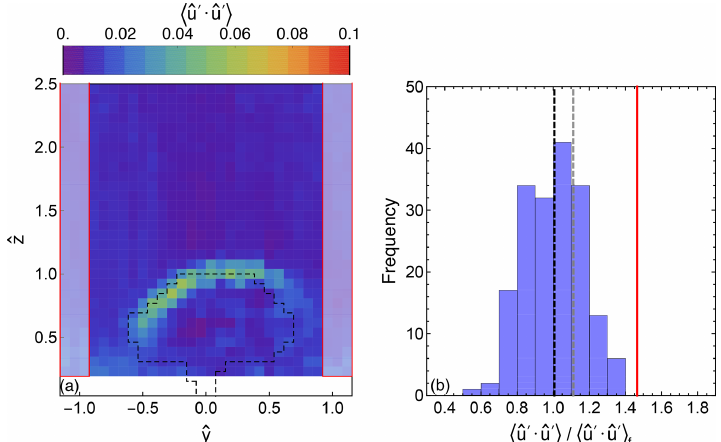
Figure B1. (a) Area used for the estimation of the reference variance of the free wind marked by the two red rectangles and (b) histogram of normalized variance (cid:104)ˆ u (cid:48) ˆ u (cid:48) (cid:105) / (cid:104)ˆ u (cid:48) ˆ u (cid:48) (cid:105) f in the selected grid cells and the corresponding median (dashed black) and upper quantile (dashed grey) as well as the upper outer-fence (red) values; (cid:104)ˆ u (cid:48) ˆ u (cid:48) (cid:105) f denotes the height-dependent variance of the u component of the free